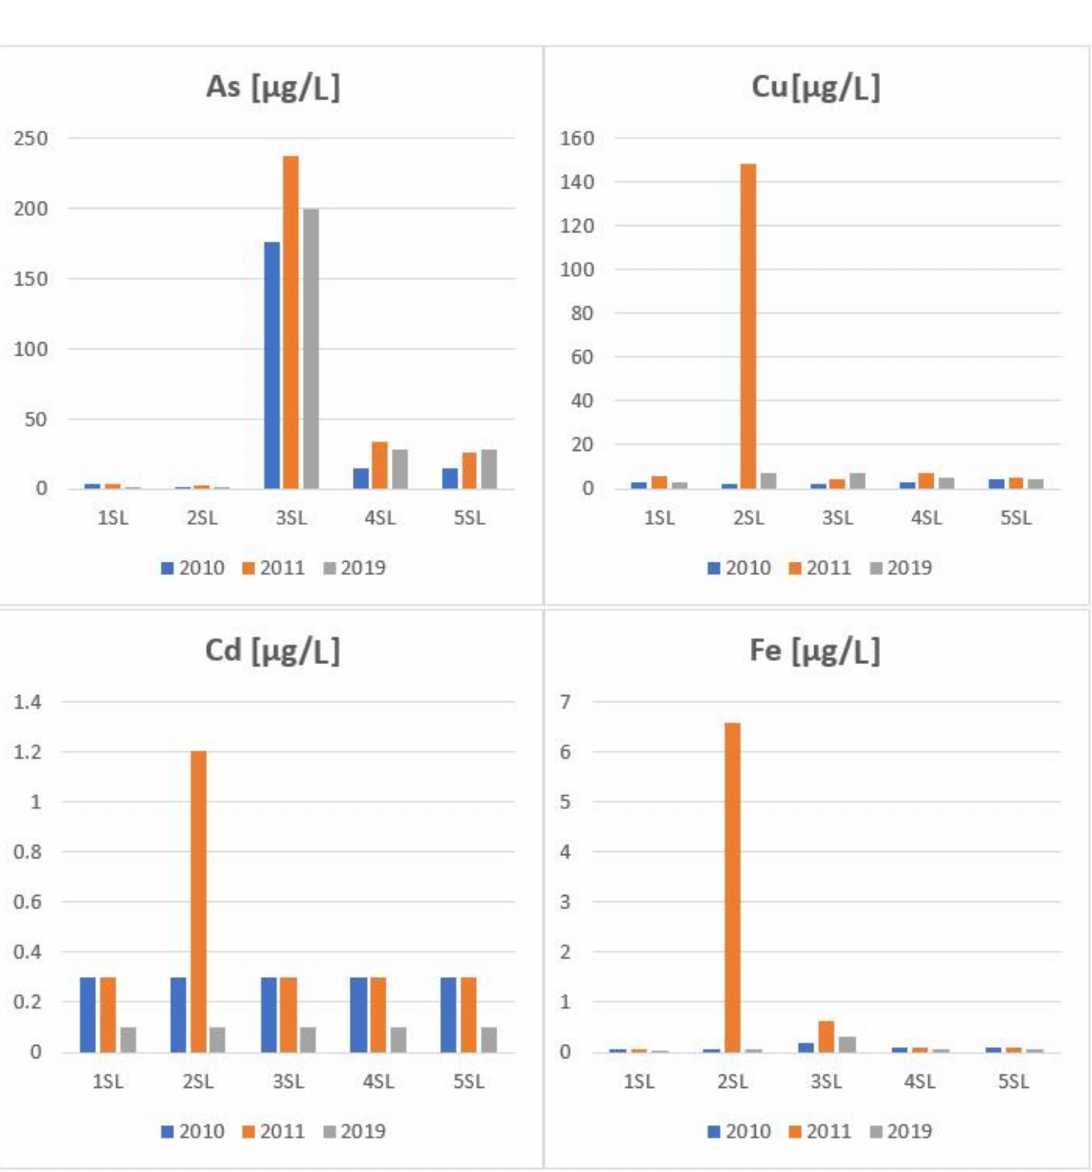
Figure 2. The measured values of risk elements in the water samples of the Slovinsk ý creek (Slovakia). (Notes: limit value Act No. 269/2010 Coll. of Laws: As—7.5 µ g/L, Cu—1.1—8.8 µ g/L, Cd—0.08–0.25 µ g/L, Fe—2 mg/L; guideline value of WHO: As—10.0 µ g/L, Cu—2000 µ g/L, Cd—3.0 µ g/L, Fe—2 mg/L, Fe—an allocation of 10% of this PMTDI (provisional maximum tolerable daily intake) to drinking-water gives a value of about 2 mg/L, which does not present a hazard to